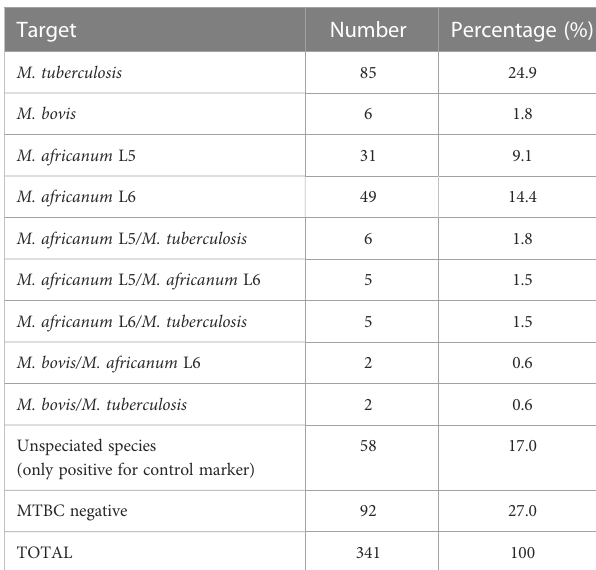
TABLE 4 Results of multiplex PCR validation using samples from 341 active TB patients in